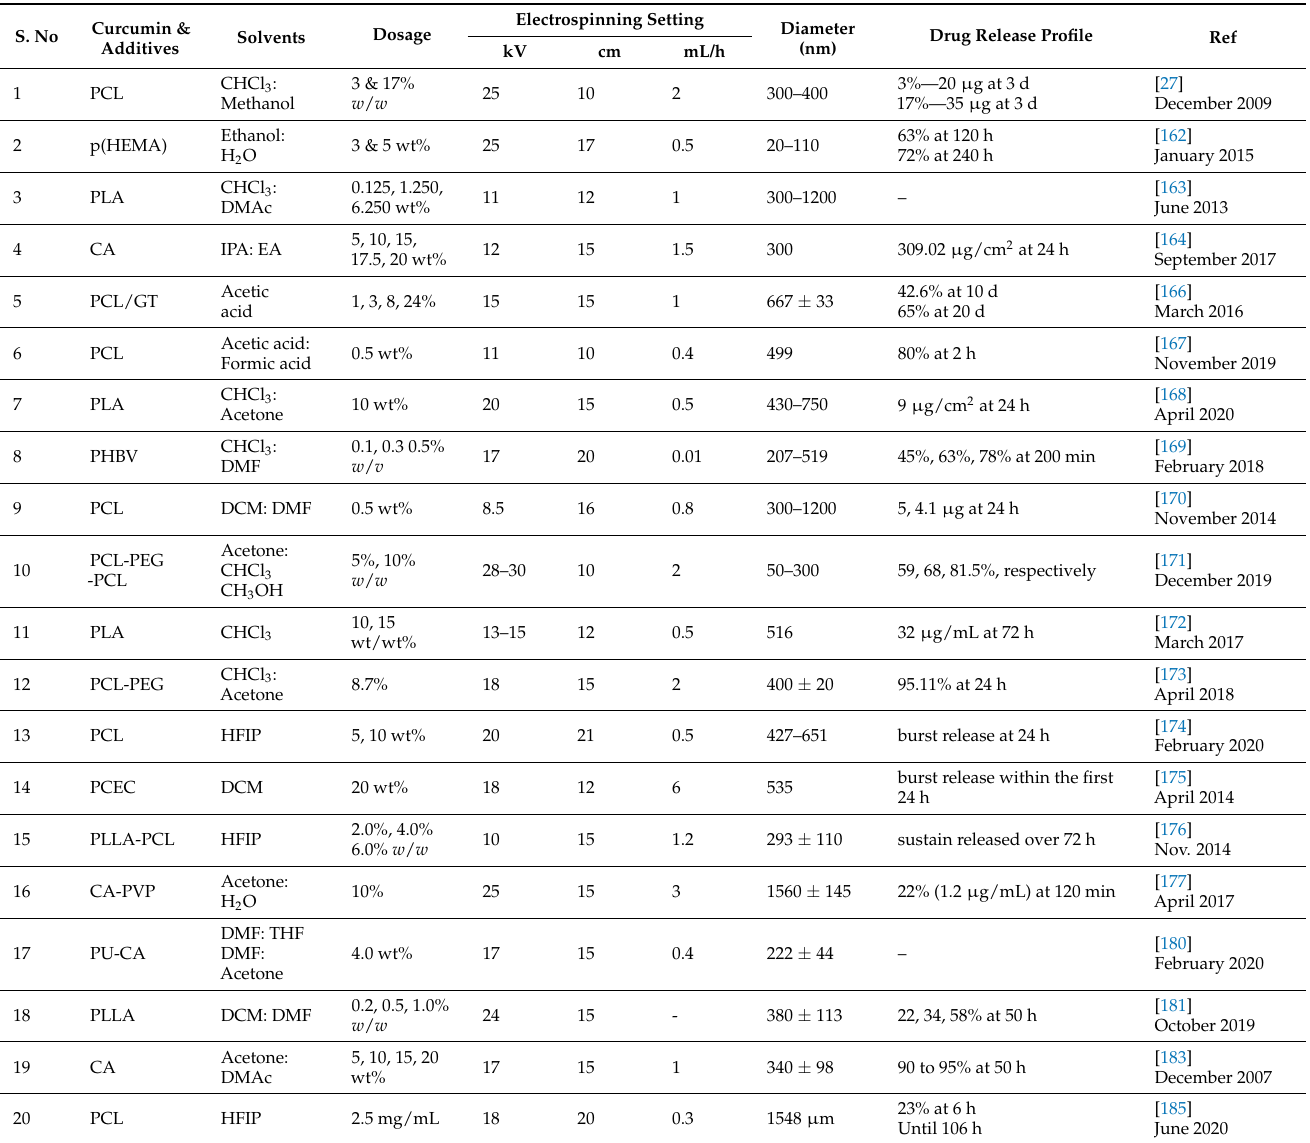
Table 6. The effect of curcumin-loaded nanofiber diameters and drug release profiles on electrospin- ning parameters and polymer/solvent